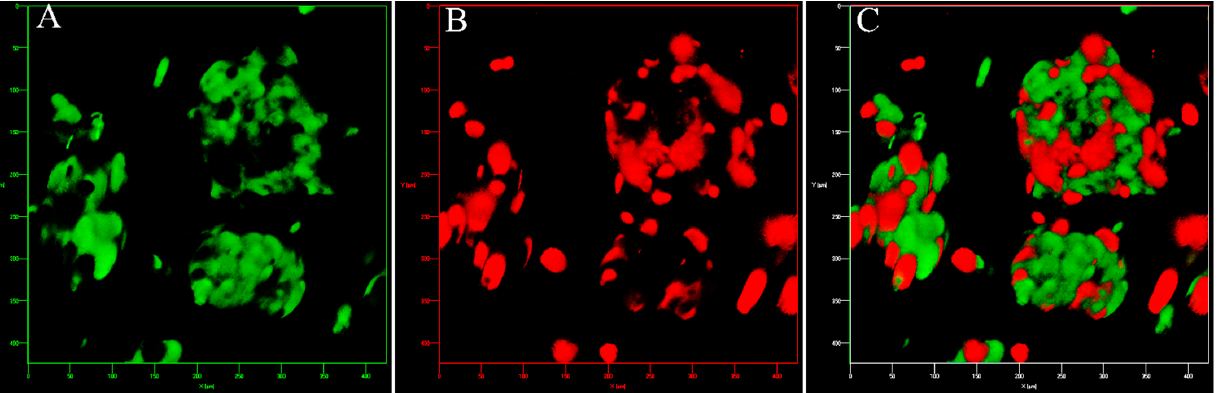
Figure 3. Three-dimensional Z-stacked image of co-cultured Hep-G2 and HUVEC clusteroids at a cell ratio of ( A – C ) 1:1 and ( D – F ) 5:1 set at different fluorescence channels: FITC ( A , D ), CFSE far-red ( B , E ), and dual fluorescence ( C , F ). The box size is 400 μ m × 400 μ m.